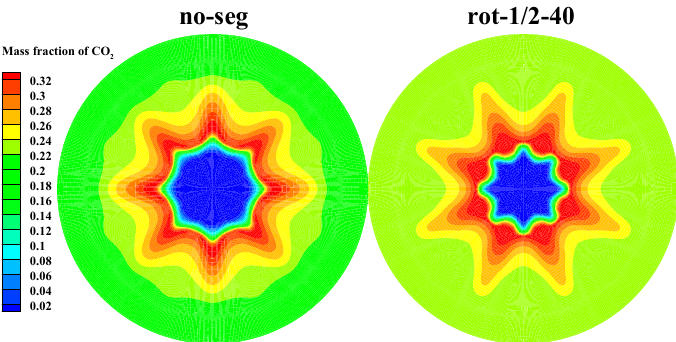
Figure 30. Mass fraction of CO 2 at the nozzle entrance.